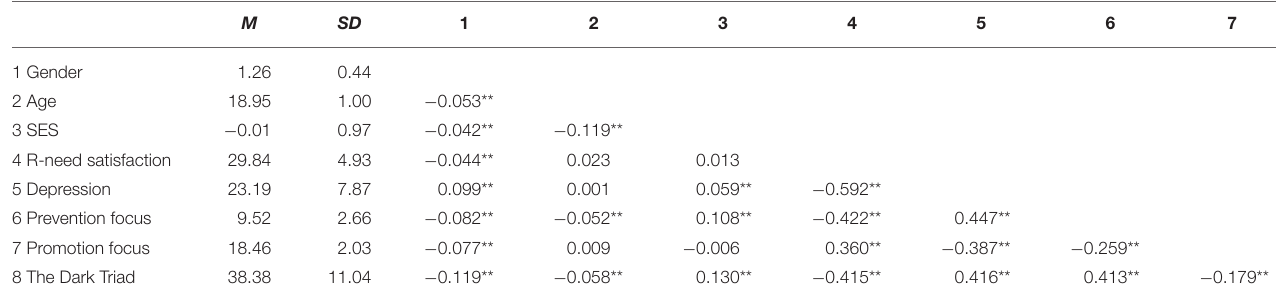
TABLE 1 | Summary of means, standard deviations, and correlations of variables of interest.